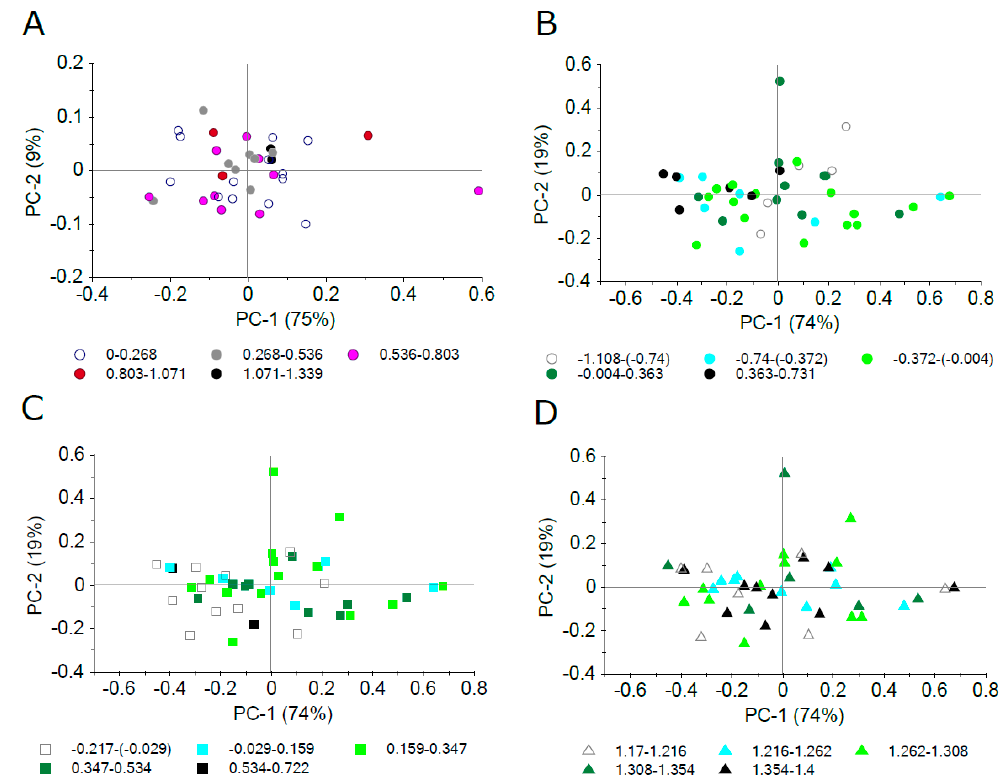
Figure 8. Principal component analysis of specular reflectance in 450–1800 nm. Sample scores are grouped into five gradual intervals of surface properties, which were automatically created by the software Unscrambler 11 (CAMO Analytics, Oslo, Norway). ( A ) A. thaliana trichome density, ( B ) Hieracium sp. trichome density (log-transformed), ( C ) Hieracium sp. trichome length (log-transformed), ( D ) Hieracium sp. adaxial epidermis thickness (log-transformed).